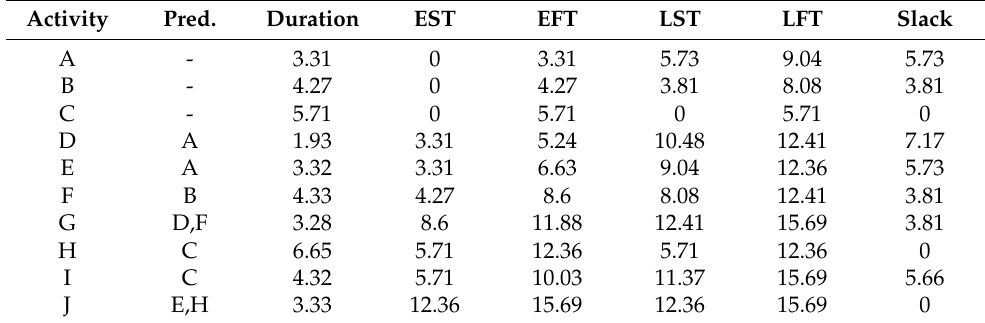
Table 4. Results of the forward and backward pass for the stochastic durations.